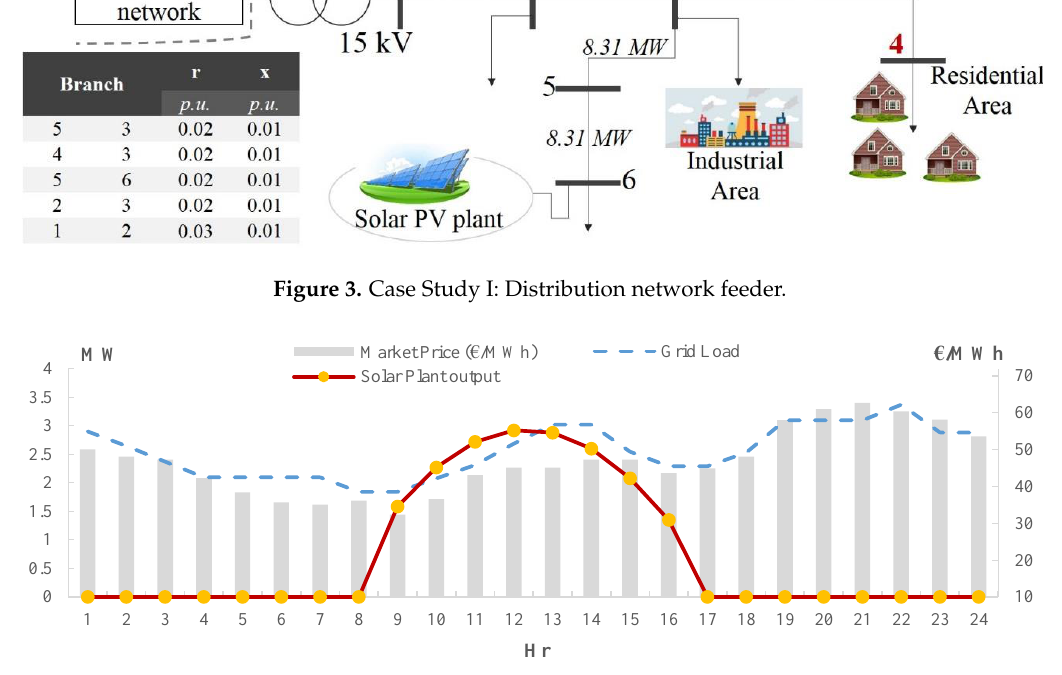
Figure 4. Forecasted load profile (MW) and PV solar production (MW) and actual day-ahead market prices (€/MWh).